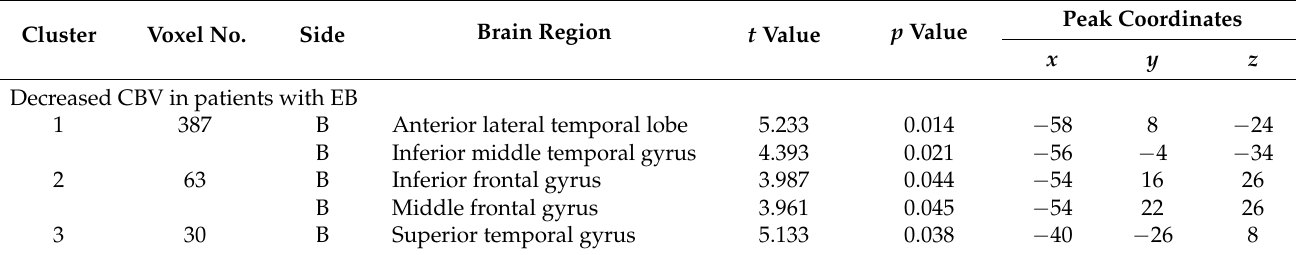
Table 3. Clusters of decreased CBV in EB group relative to controls.